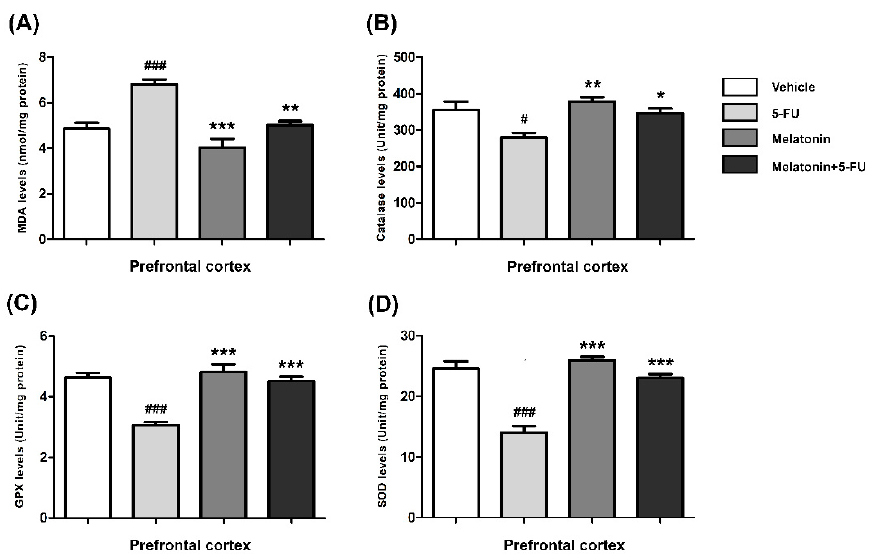
Figure 4. MDA ( A ), CAT ( B ), GPX ( C ) and SOD ( D ) levels in the PFC. # p < 0.05 and ### p < 0.001 compared with the vehicle group. * p < 0.05, ** p < 0.01 and *** p <0.001 compared with the 5-FU group. Malondialdehyde: MDA; catalase: CAT; glutathione peroxidase: GPX; superoxide dis- mutase: